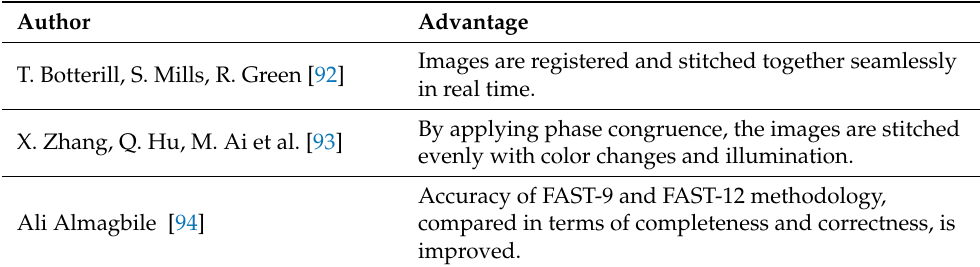
Table 4. FAST applied on